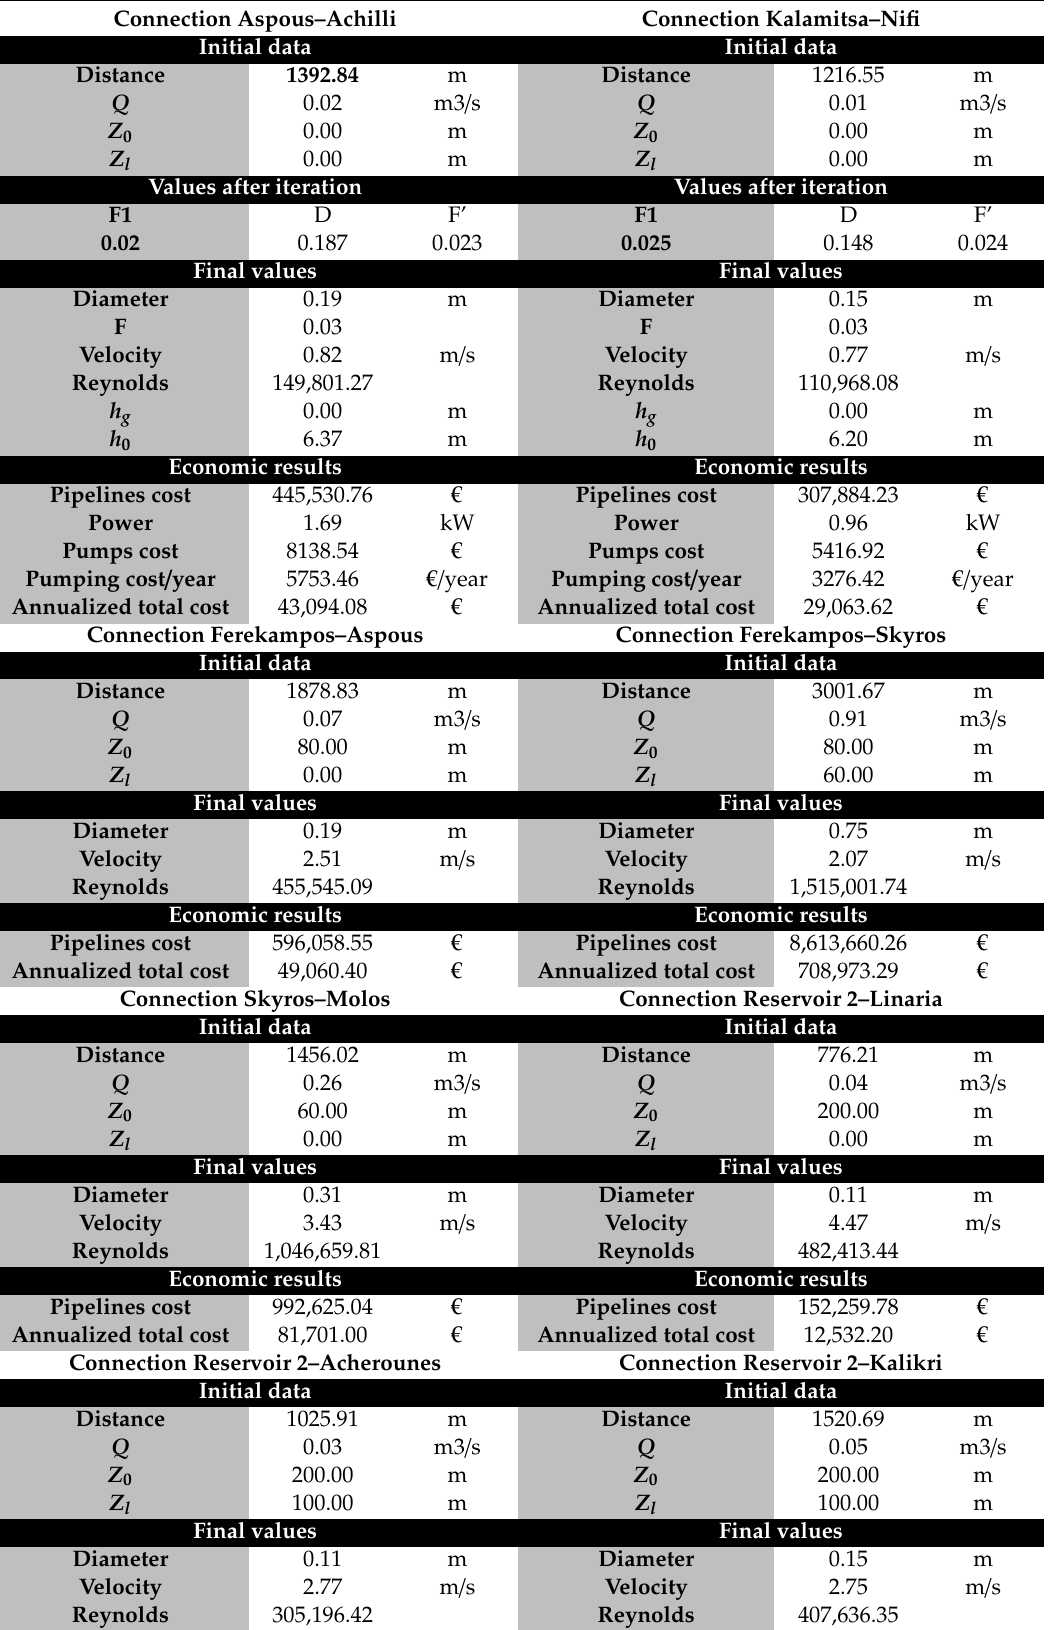
Table A7. Configuration of the network for drinking